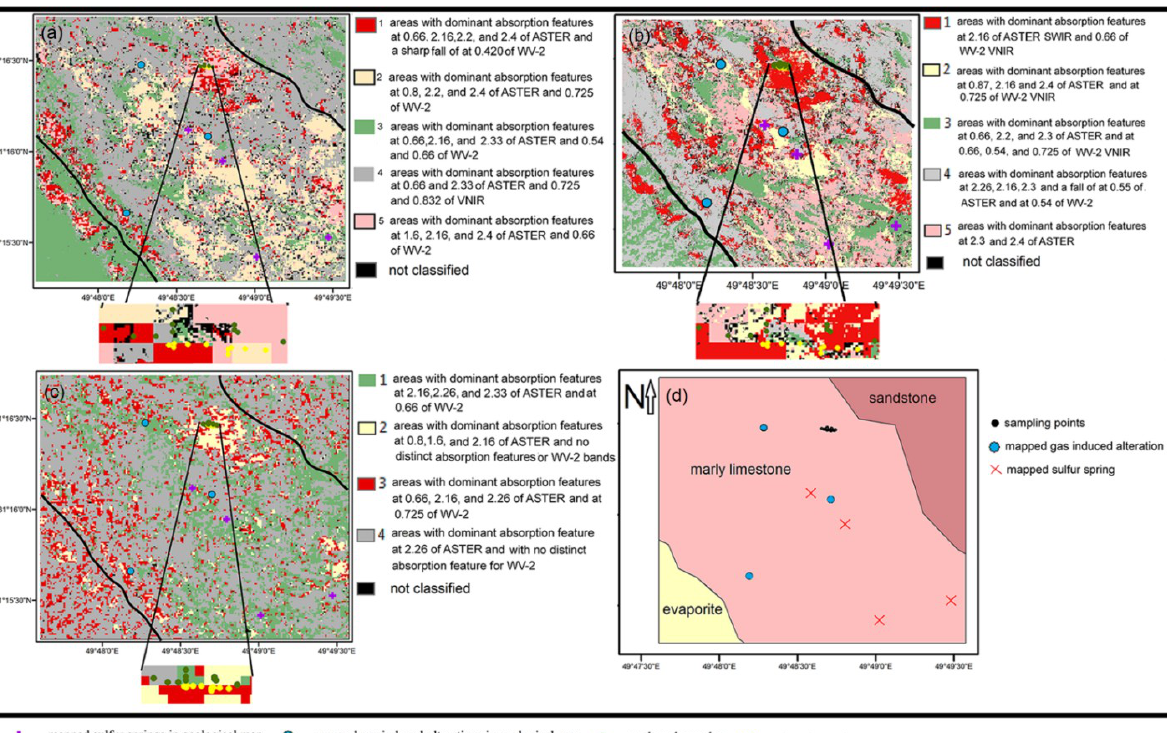
Figure 11. The results obtained by BRT classification of multiple band imagery created from ASTER and WV-2. ( a ) The BRT classification using ROIs co-located with the purest pixels of ASTER. ( b ) The BRT classification using ROIs co-located with the purest pixels of WV-2. ( c ) The BRT classification using ROIs co-located with sampling points. ( d ) The geological map of the study